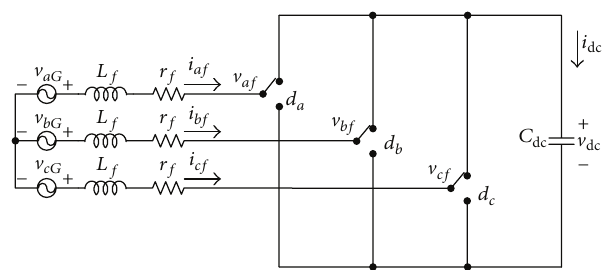
Figure 2: Equivalent circuit of active power